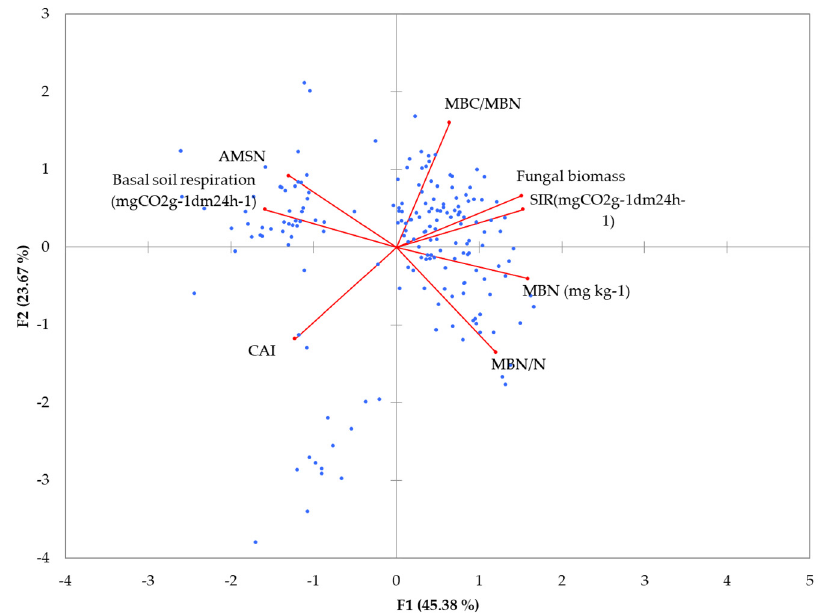
Figure 4. PCA biplot result of soil biological characteristics.